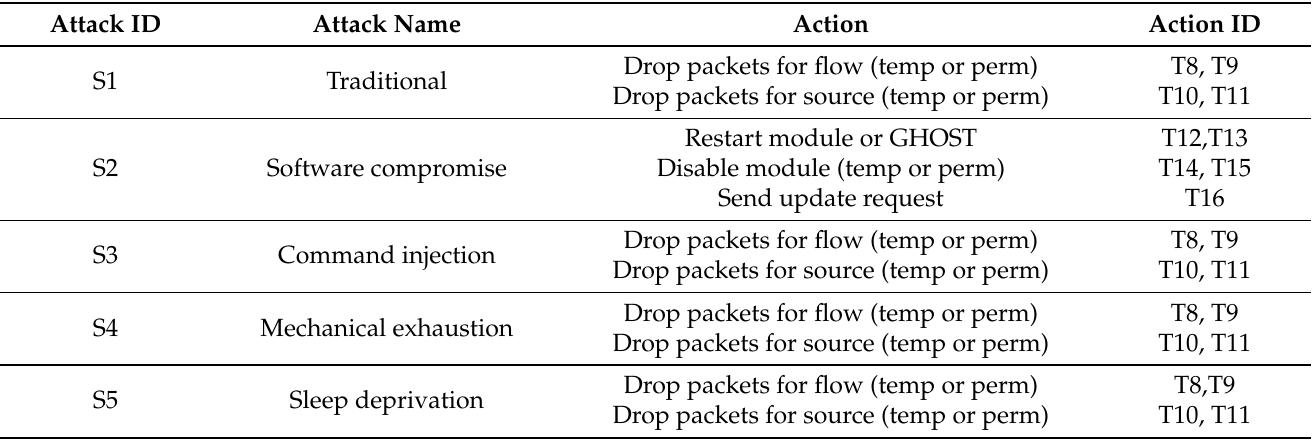
Table 6. Technical actions in software